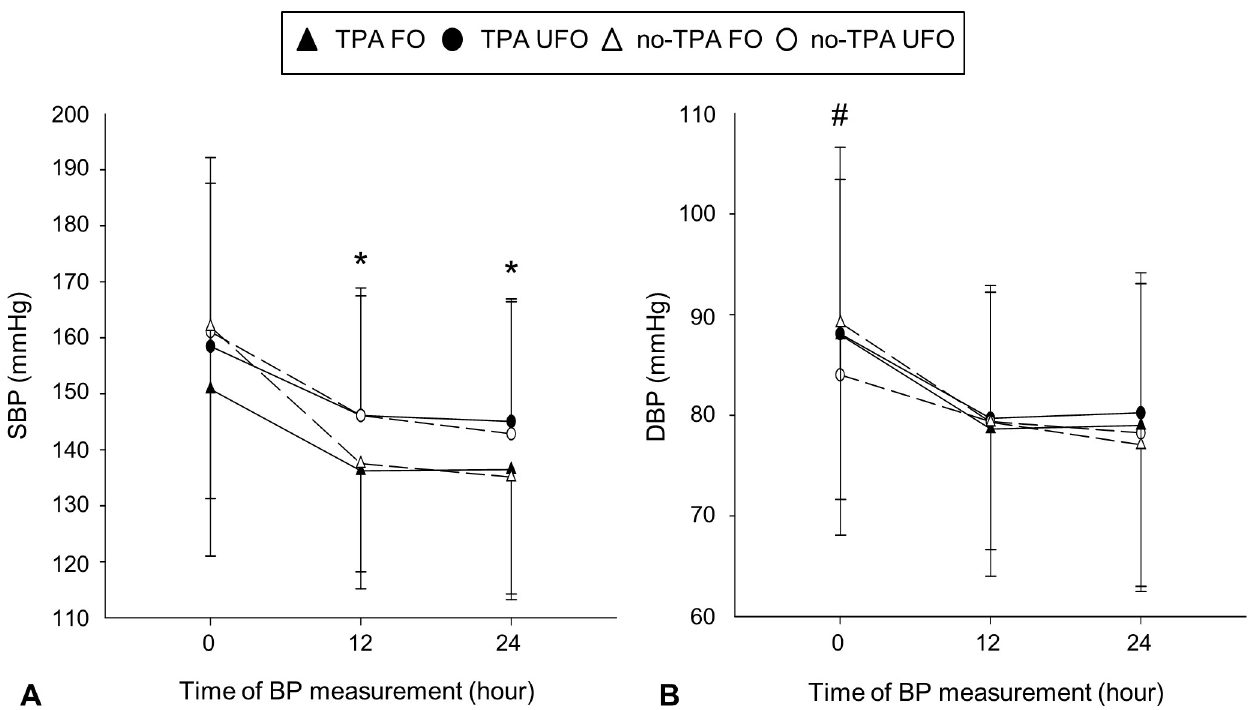
Fig 1. Blood pressure (BP) according to time of BP measurement after admission. (A) Patients with favorable outcomes (TPA FO and no-TPA FO groups) had lower systolic BPs after 12 and 24 hours than those with unfavorable outcomes (TPA UFO and no-TPA UFO groups, � ). (B) The initial diastolic BP of patients in the no-TPA FO group was higher than that of patients in the no-TPA UFO group (#).